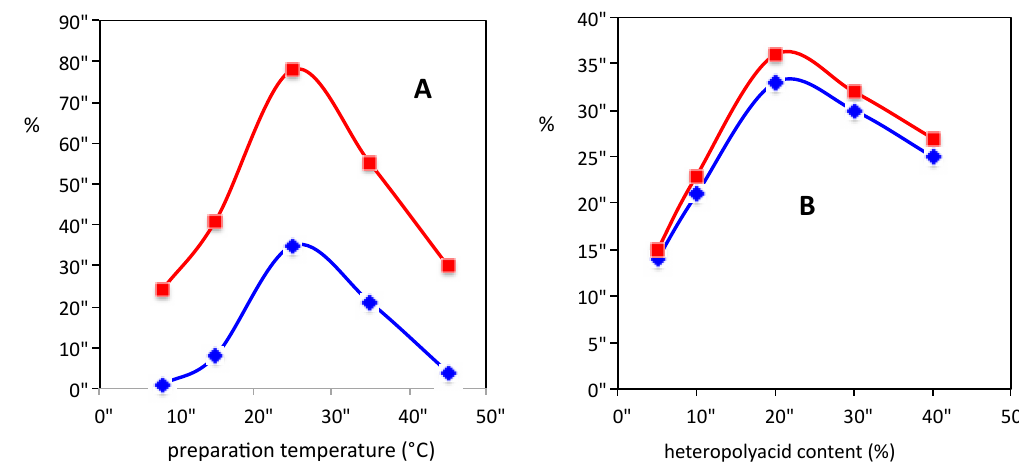
Figure 5. Catalytic performance of Pd catalysts as a function of the preparation temperature ( A ) and the heteropolyacid content ( B ) according to Ref. 90. A : conversion (squares), yield (diamonds); B : selectivity (squares), yield (diamonds).